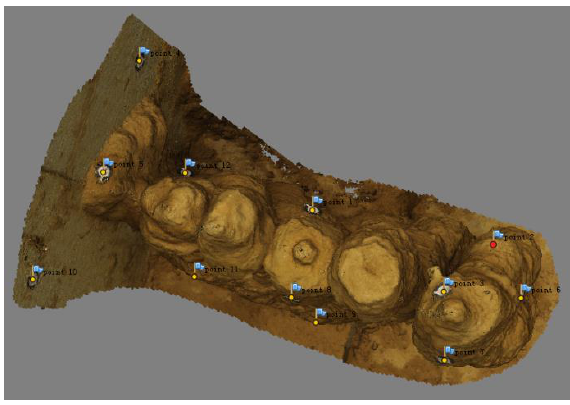
Figure 7. Distribution of markers and numbering (top